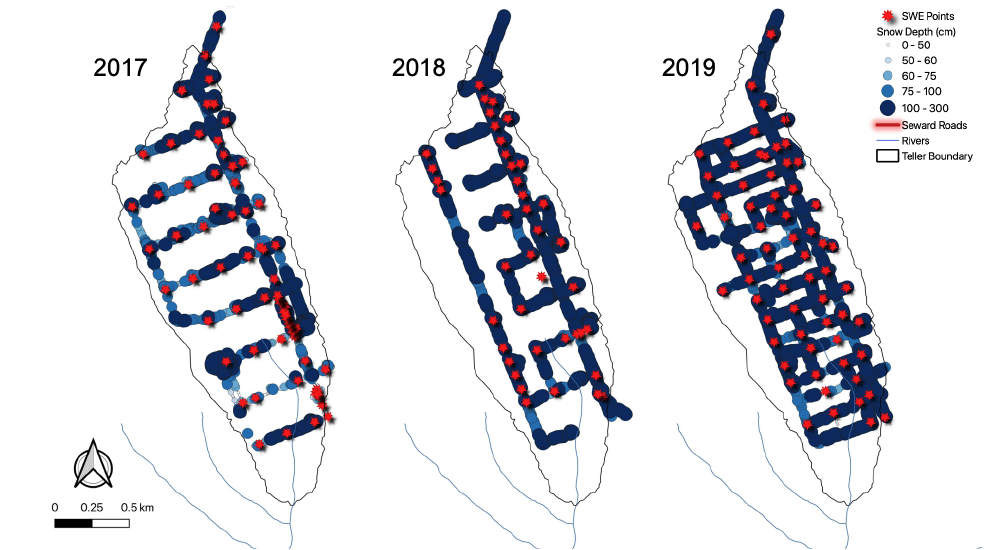
Figure A3. Teller snow depth and SWE measurements for each year of the survey.